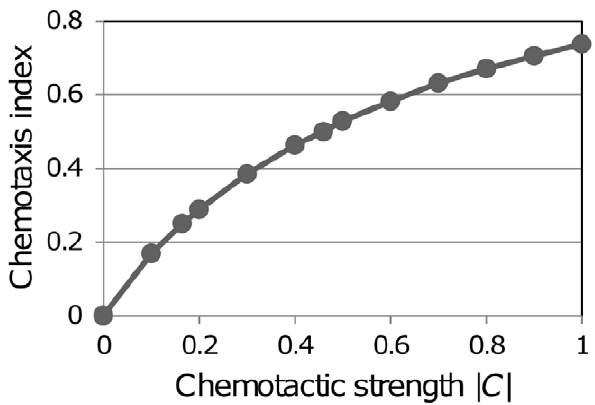
Figure 9. Dependence of chemotaxis index on the chemotactic strength | C |. Simulations were conducted to investigate the motion of a cell subject to a uniform (non-spatially varying) chemotactic influence C . The chemotaxis index (CI) is the ratio of the straight-line displacement in the direction of C to the path length, for 10 steps on the lattice (this is a modification of the McCutcheon index). The chemotactic strength | C | was varied between 0 and 1, and in each case the CI was determined as the average of 1000 simulations.